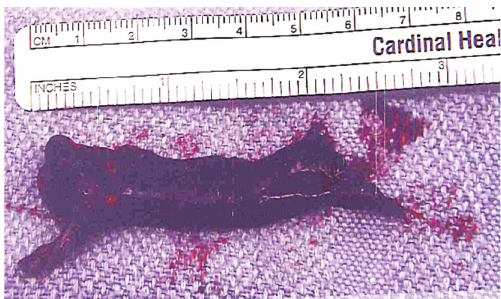
Figure 2: The thrombus removed from the left pulmonary